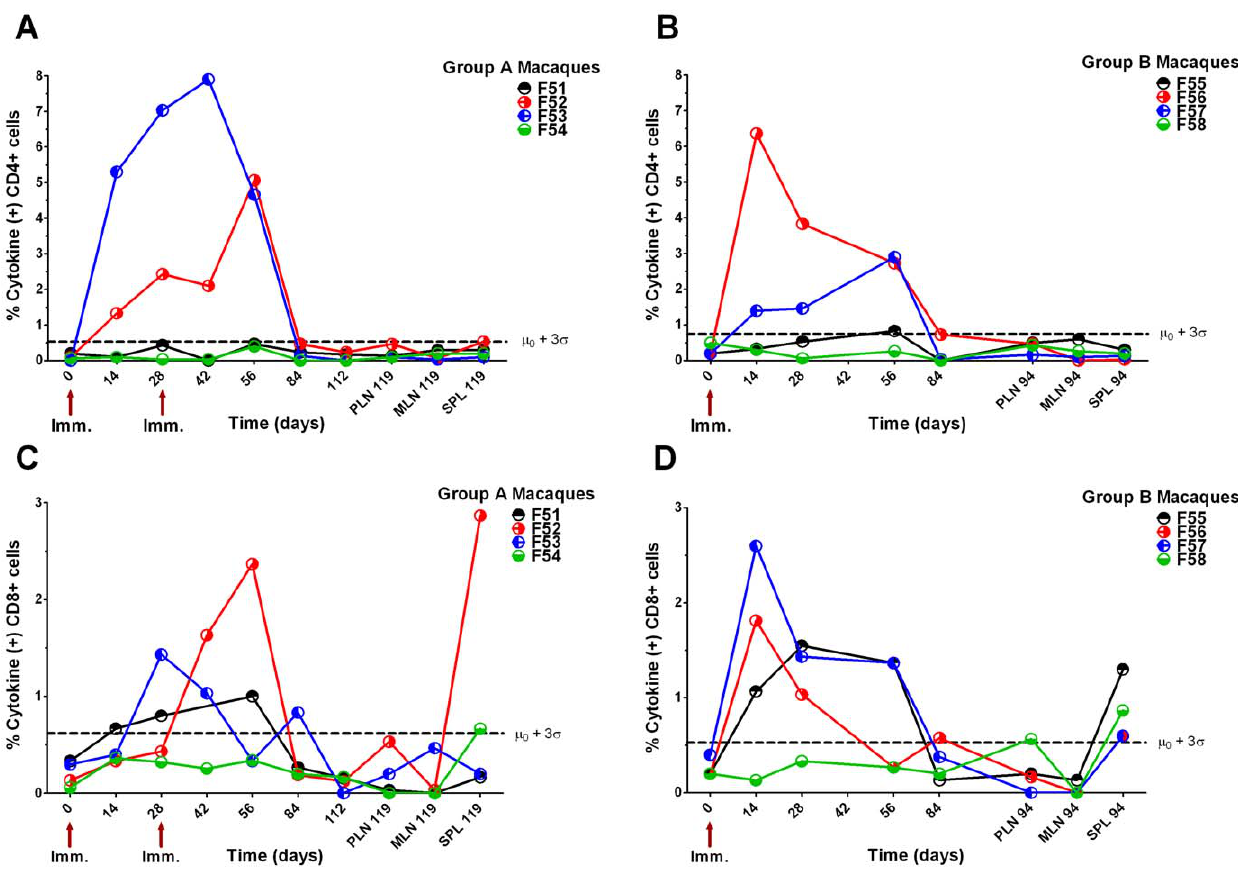
Figure 3. Macaque T cell cytokine responses to HIV-1 F4 peptides. Total cytokine (sum of TNF a + , IL-2 + and IFN c + cells) response to F4 peptides by CD4 + and CD8 + T cells from peripheral blood (PBMCs), peripheral lymph nodes (PLN), mesenteric lymph nodes (MLN) and spleen (SPL). Time in days is shown on x-axis, all responses from PBMC unless prefixed by a tissue. Group A, macaques F51–F54, were immunised with 10 5 TCID 50 MV1-F4 on days 0 and 28 whilst group B, macaques F55–F58, were immunised on day 0 only. Panels A and B shows cytokine responses gated on CD4 + T cells. Panels C and D show cytokine responses gated on CD8 + T cell. Dashed line represents the mean plus 3 standard deviations of day 0 responses, above which points were deemed